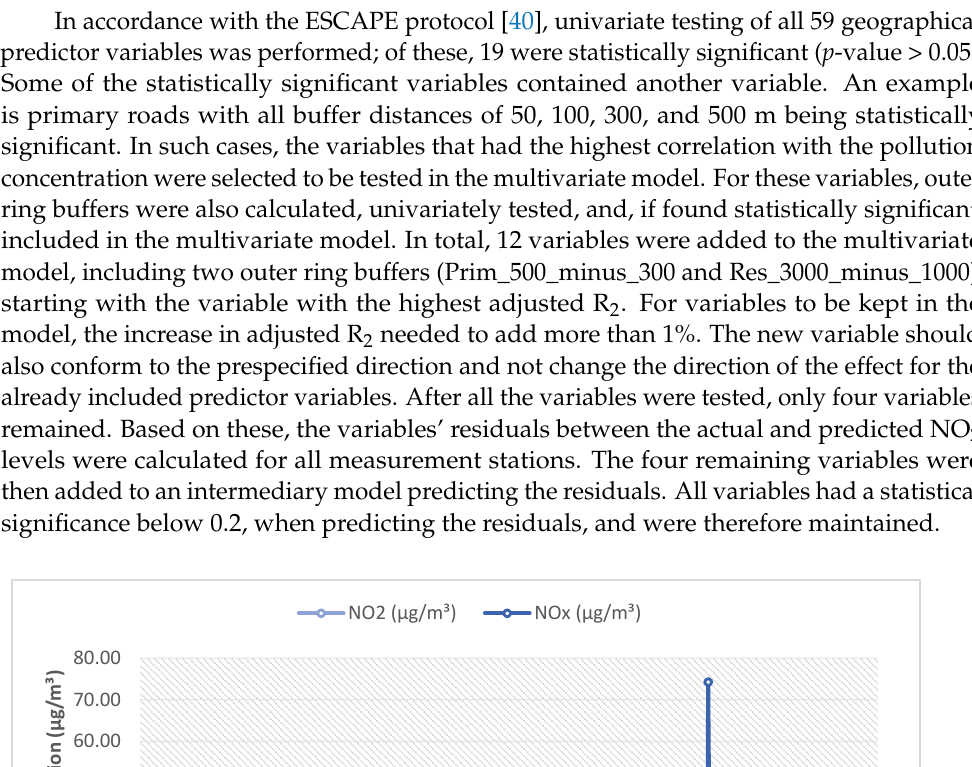
Figure 3. Diurnal trend of NO 2 and NO x in Adama City, averaged from 13 days with complete data.